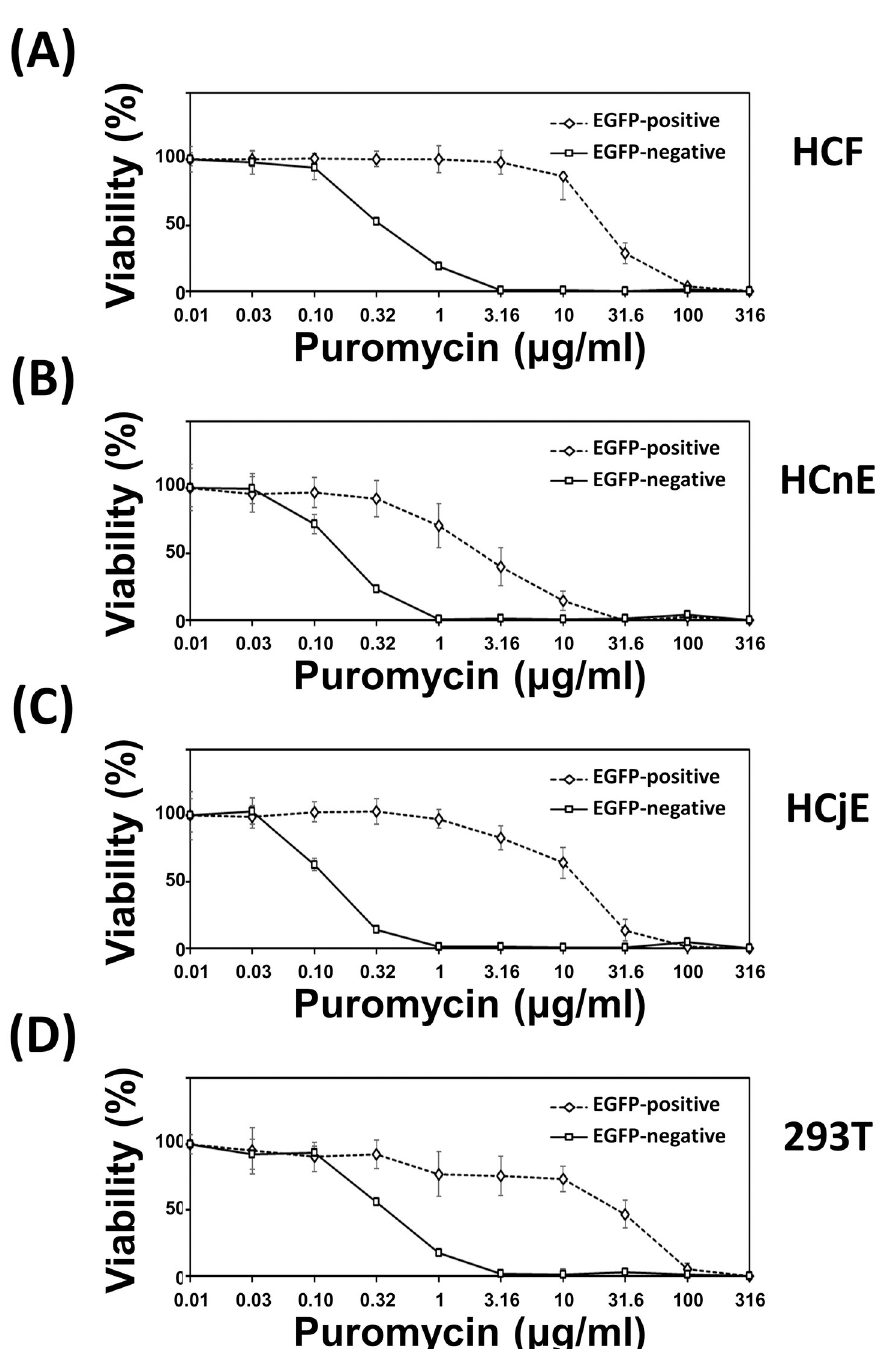
Fig 6. Tolerance to puromycin of the sorted EGFP-expressing cells. All EGFP-positive and EGFP-negative cells were subjected to repeated cell sorting to achieve > 95% purity. Each cell type was seeded into individual wells of a 96-well plate: (A) 2.0 × 10 3 HCFs, (B) 2.0 × 10 4 HCnEs, (C) 2.0 × 10 4 HCjEs, and (D) 2.0 × 10 4 HEK-293T cells. At 24 h post- seeding, the medium was refreshed, and both EGFP-positive and EGFP-negative cells were incubated with a series of 3.16-fold dilutions of puromycin ranging from 0.01 to 316 μ g/ml. After incubation for 48 h, cell viability was analyzed with the CCK-8 reagent. Data are expressed as the mean ± S.D. from three independent experiments. The bars correspond to the S.D. of the mean.